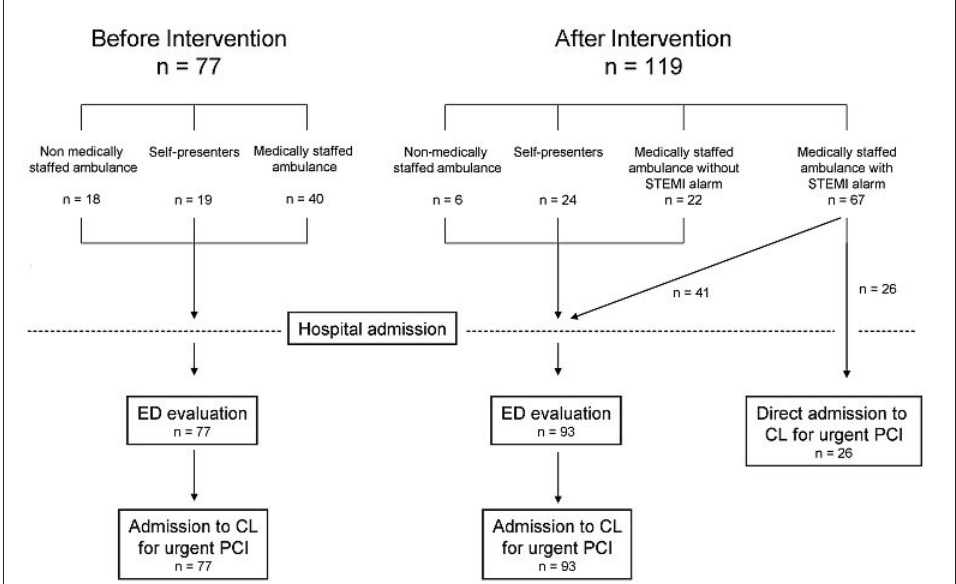
Admission mode and in-hospital flow of STEMI patients, before and after intervention (ED = emergency depart- ment, CL = catheteri- sation laboratory, PCI = percutaneous coronary interven- tion).